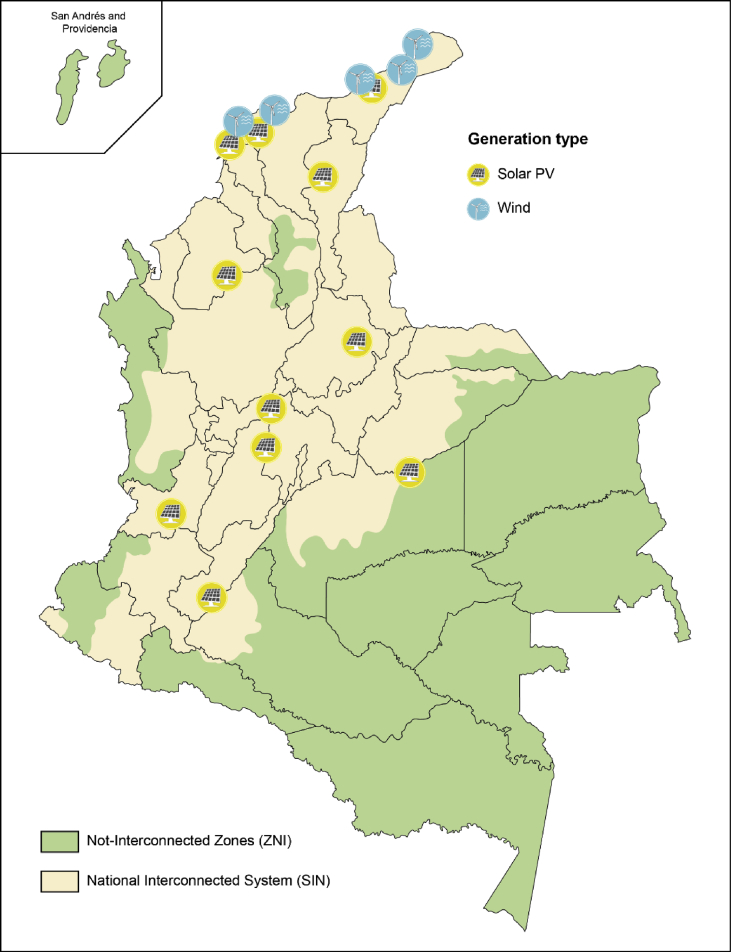
RES generation sites registered in SIEL [3].